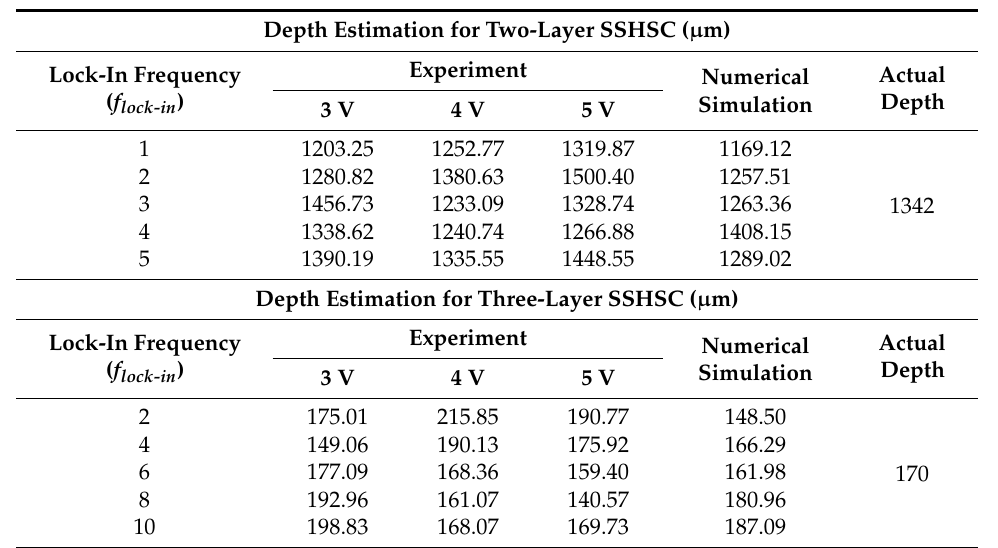
Table 2. Estimated depth for the two-layer SSHSC and three-layer